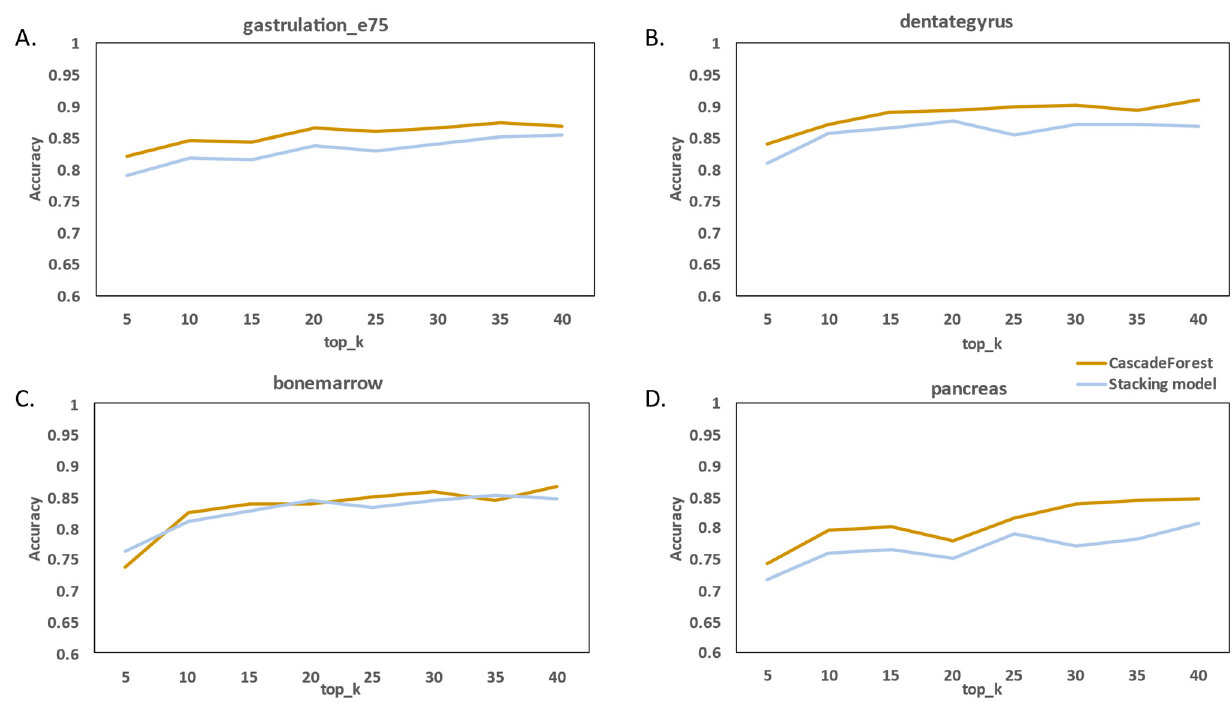
Figure 4. The effects of hyper-parameter k. ( A – D ) Performance of cascade forest models and stacking models under different datasets and different parameters k.